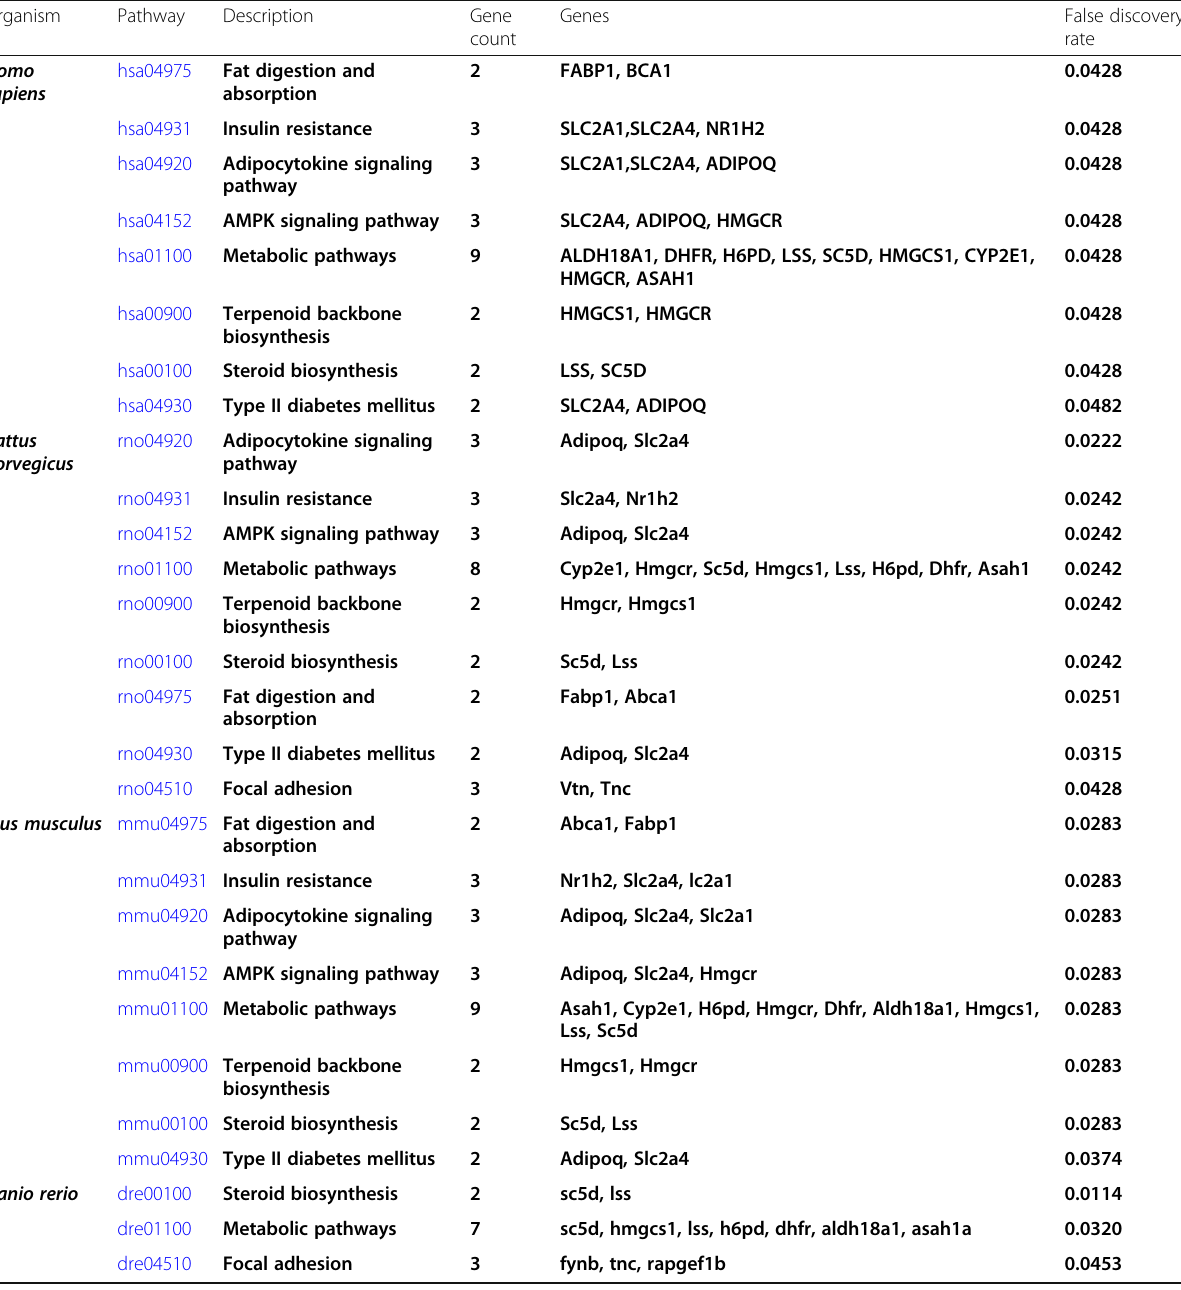
Table 2 Olanzapine-induced gene set enrichment analysis in Homo sapiens , Rattus norvegicus , Mus musculus , and Danio rerio Organism Pathway